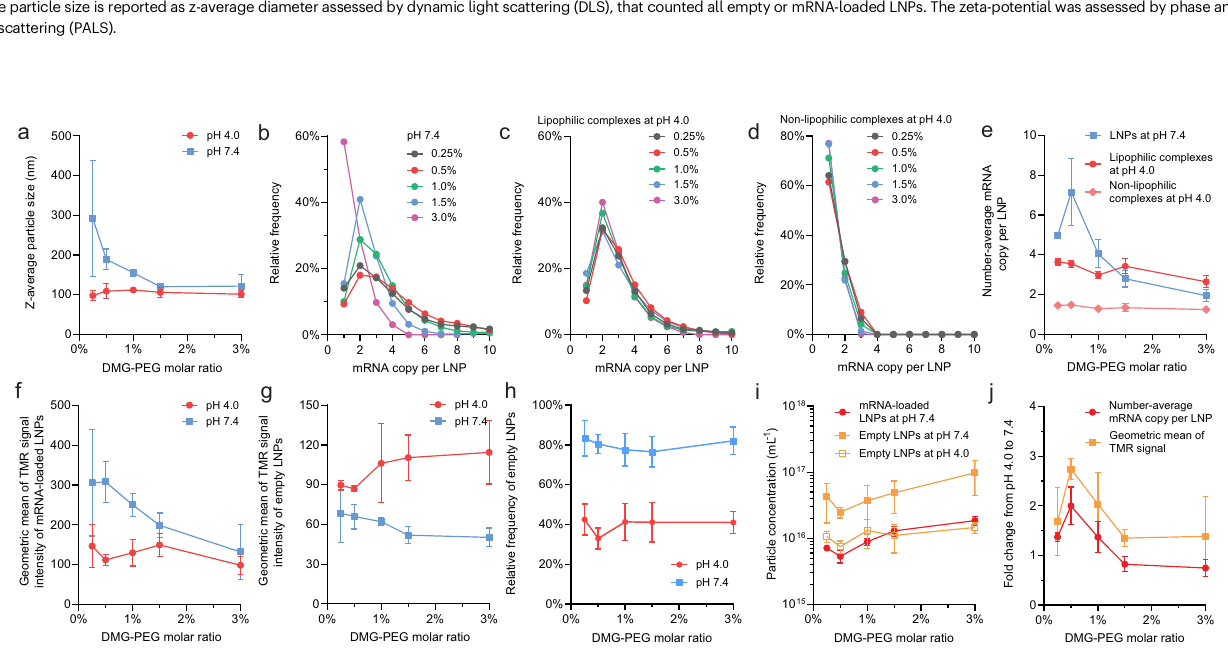
pH4.0or7.4. h ThefractionofemptyLNPs. i Theabsolutenumberconcentrations of mRNA-loaded or empty LNPs at pH 7.4. j The average fold change of mRNA payload and helper lipid content from lipophilic complexes at pH 4.0 to mRNA- loaded LNPs at pH 7.4. The consistently higher fold change of helper lipid content indicatedthatmergeofemptyLNPstolipophiliccomplexesoccurred. a , e , f – j ,data are represented as mean value±SD, derived from n =3 independent experiments (formulating LNPs from raw materials and then applying CICS analysis), exceptfor 1.5% DMG-PEG where n